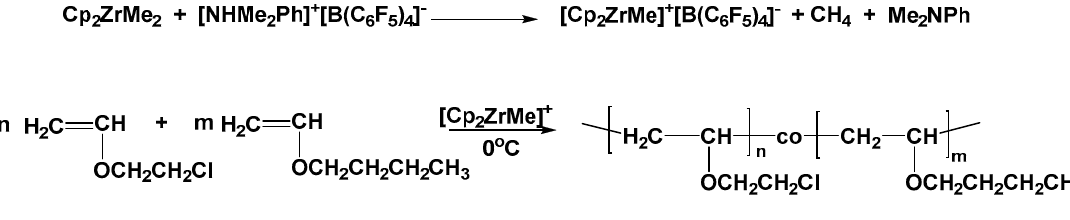
Scheme 1. Synthesis of the statistical copolymers PBVE-co-CEVE. Table 1. Molecular characteristics of the statistical Table 1. Molecular characteristics of the statistical copolymers.